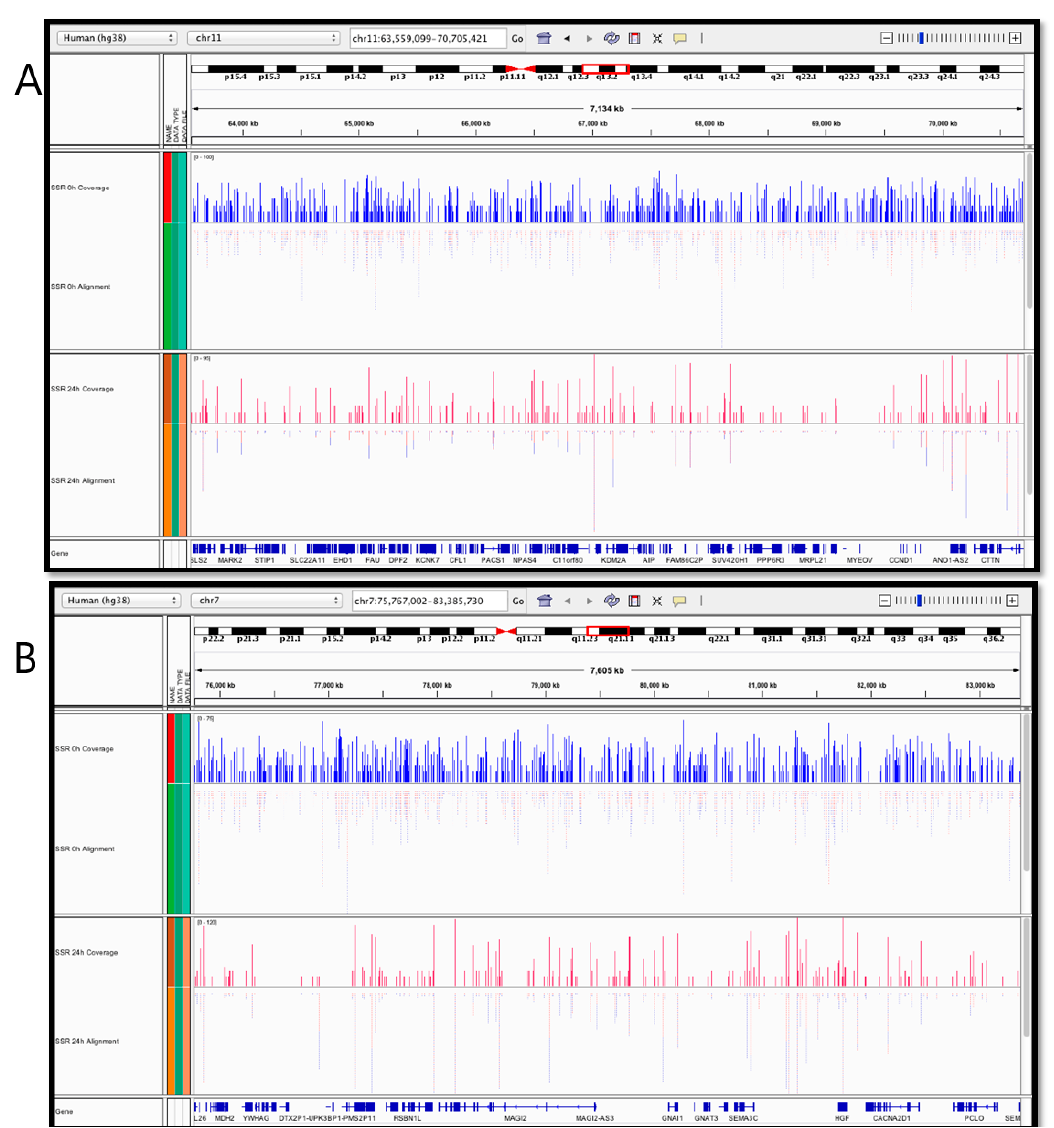
Figure 4. Screenshot of a representative Integrated Genomics Viewer [32] visualisation of the alignment of SSR-irradiated samples at 0 and 24 h post SSR exposure, mapped to human genome reference GRCh38 at (A) a 7134 kb region of chromosome 11, q13.2; and (B) a 7605 kb region of chromosome 7, q21.11. The blue (0 h, immediately after irradiation) and red (24 h after irradiation) coverage tracks correspond to the depth (number) of reads at each position. The pale pink and blue lines (below the solid blue and red lines in the upper and lower panels, respectively) represent the reads on both forward and reverse strands.